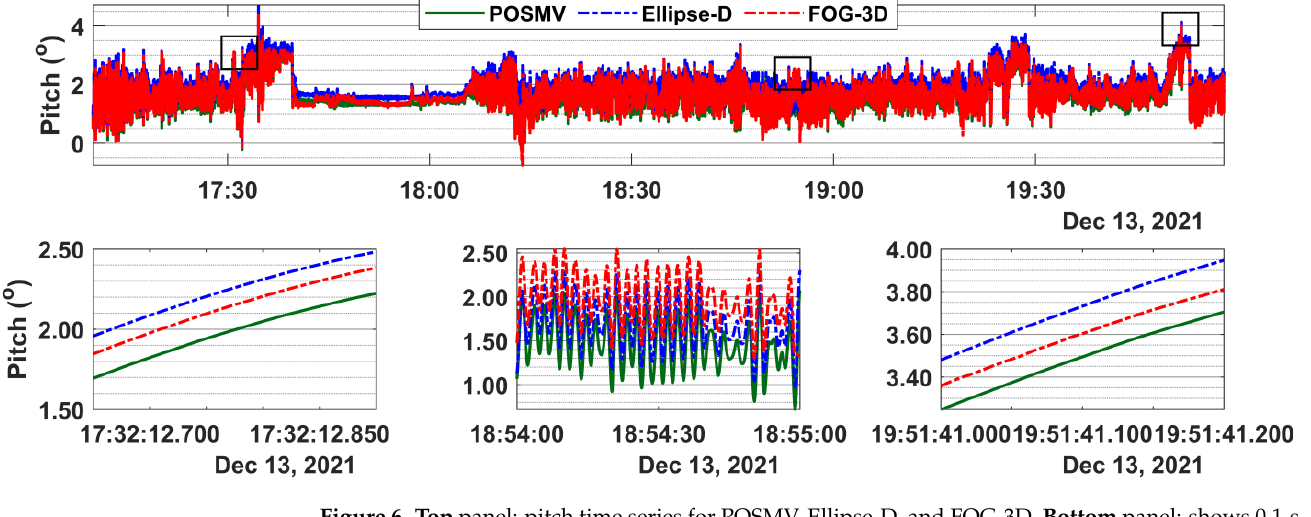
Table 4. Mean and 95% ordered statistics for attitude and elevation offsets from POSMV.